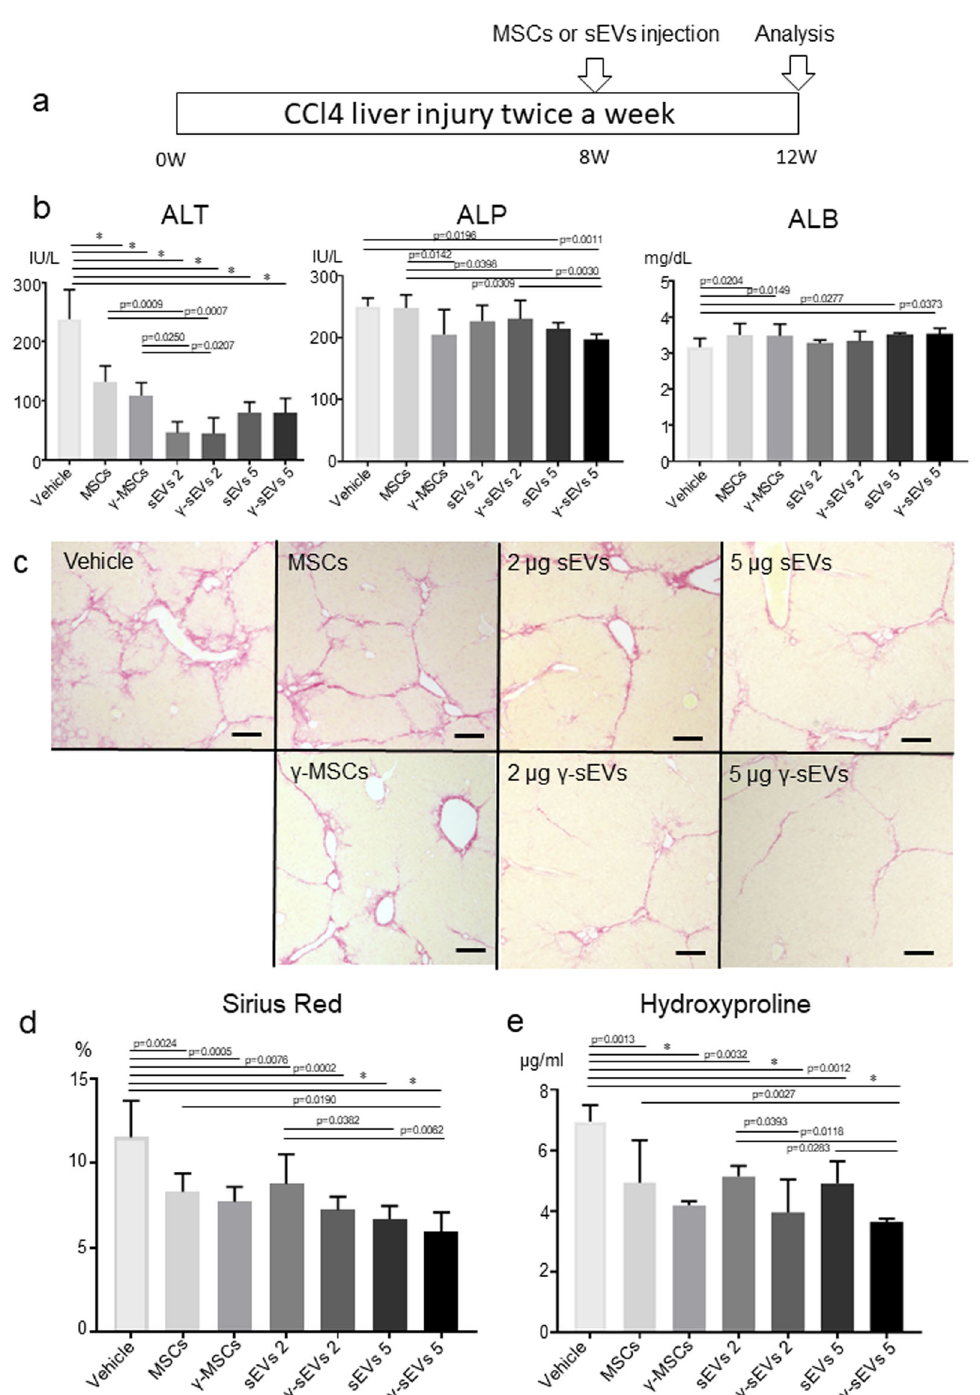
Fig. 3 Therapeutic effect of AD-MSC (MSC), γ -AD-MSC ( γ -MSC), AD-MSC-sEVs (sEVs), and AD-MSC- γ -sEVs ( γ -sEVs). a Schematic showing the experimental design for induction of fi brosis, cell or sEV administration, and analysis. b Serum levels of ALT, ALP, and ALB. Data are presented as means ± SD; n = 5 per experiment. c Representative Sirius Red staining of vehicle, MSC, γ -MSC, sEVs2, γ -sEVs2, sEVs5, and γ -sEVs5 groups. d Evaluation of fi brosis from Sirius Red-stained areas and e quantitation of hydroxyproline levels. Data are presented as means ± SD; n = 5 per experiment. * p <